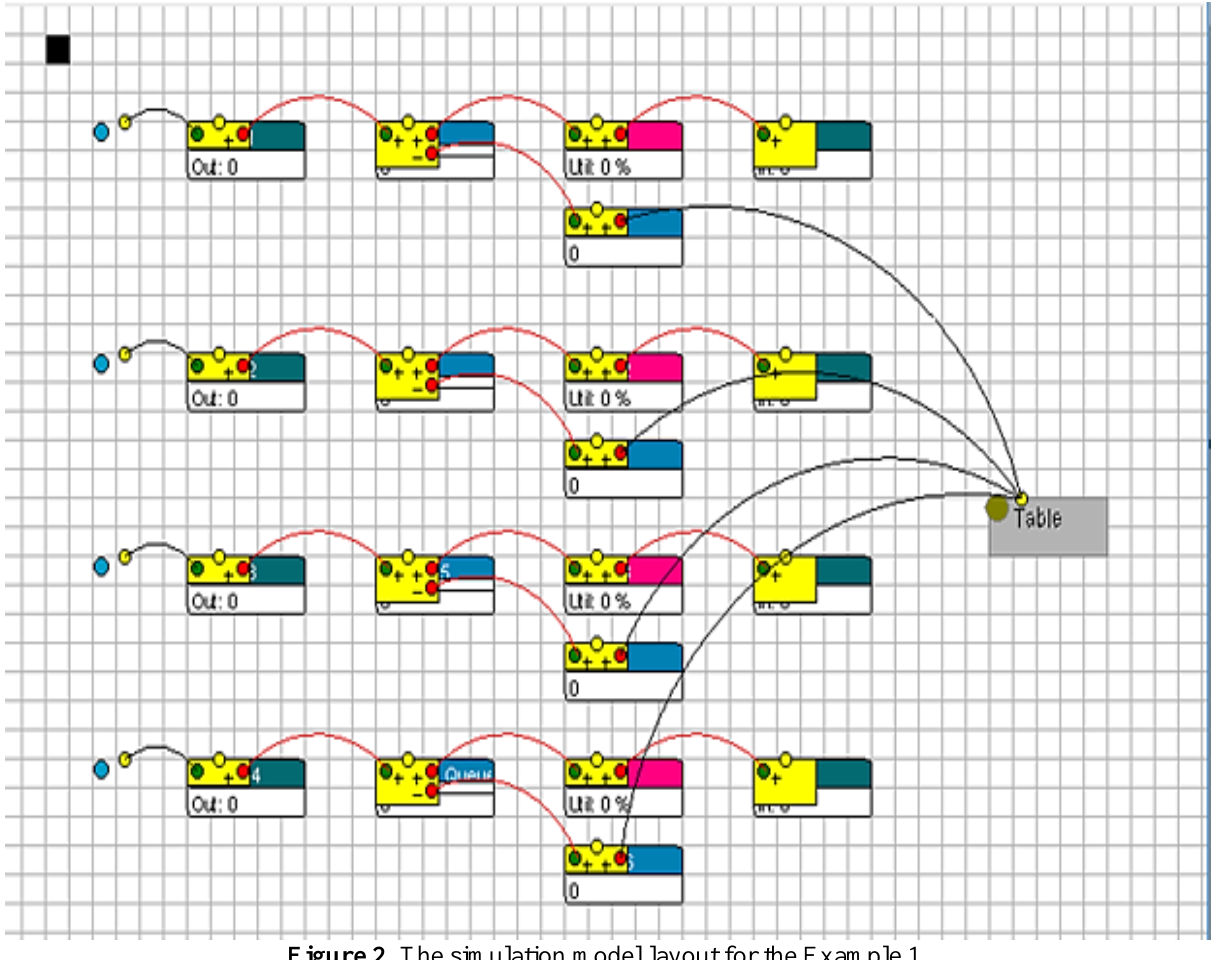
Figure 2. The simulation model layout for the Example